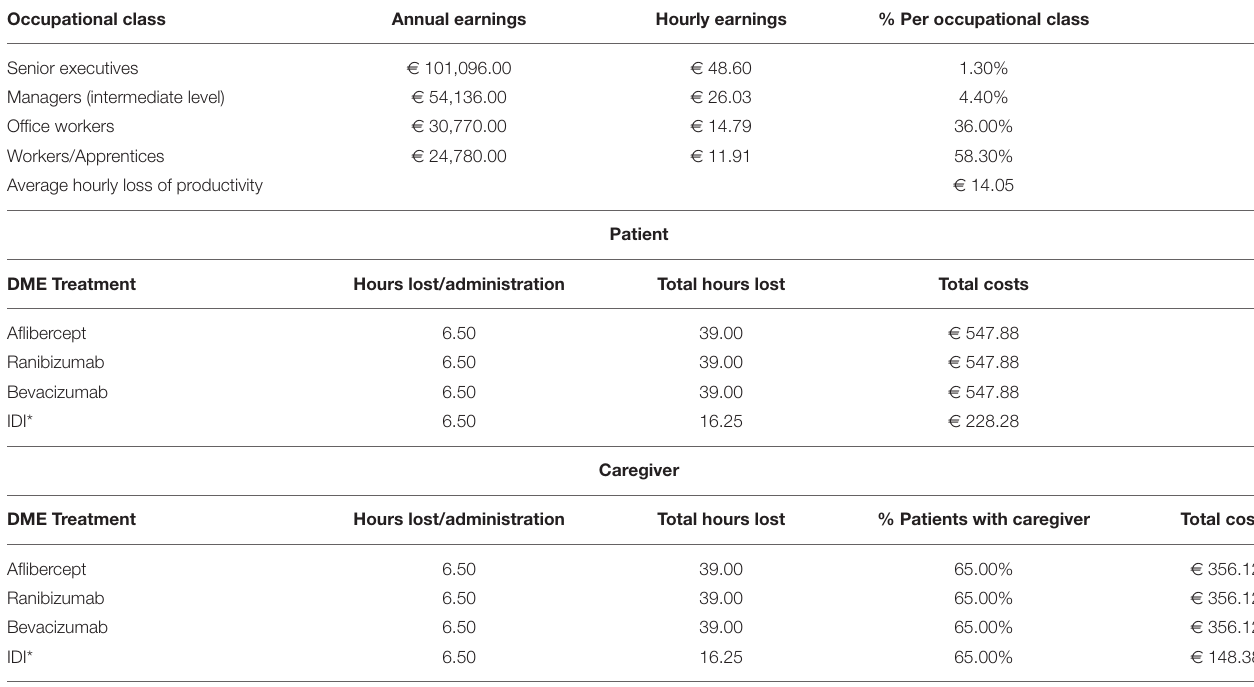
TABLE 3 | Hourly earnings by occupational class and percentage of workers/caregivers in each